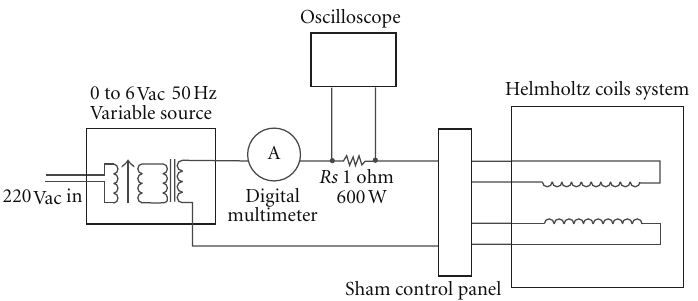
Figure 1: Experimental apparatus employed for oscillating magnetic field